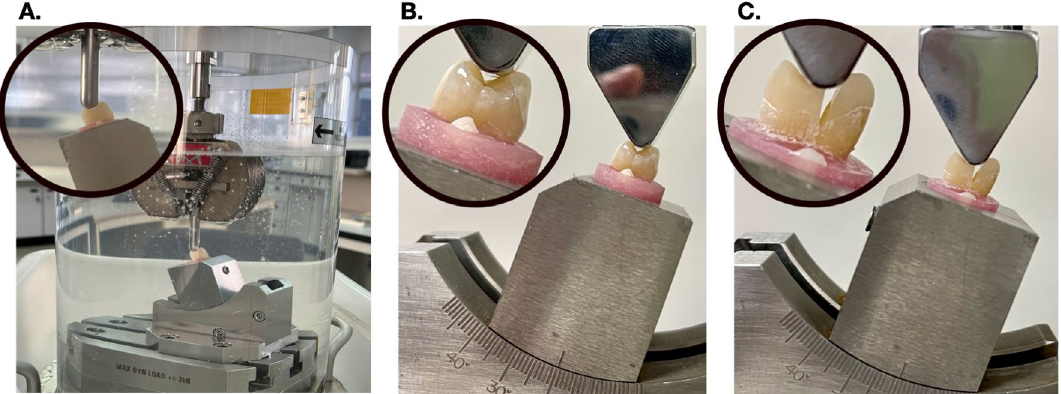
Figure 3. The specimens subjected to dynamic load in distilled water ( A ). The fracture resistance test on sound tooth (control) ( B ) and restored tooth ( C